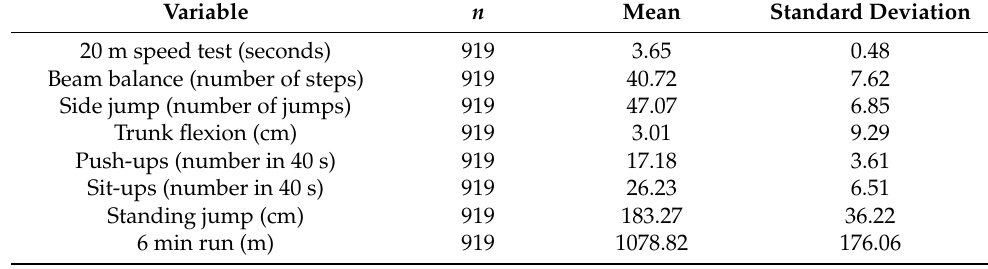
Table 2. Descriptive results for the observed variables.